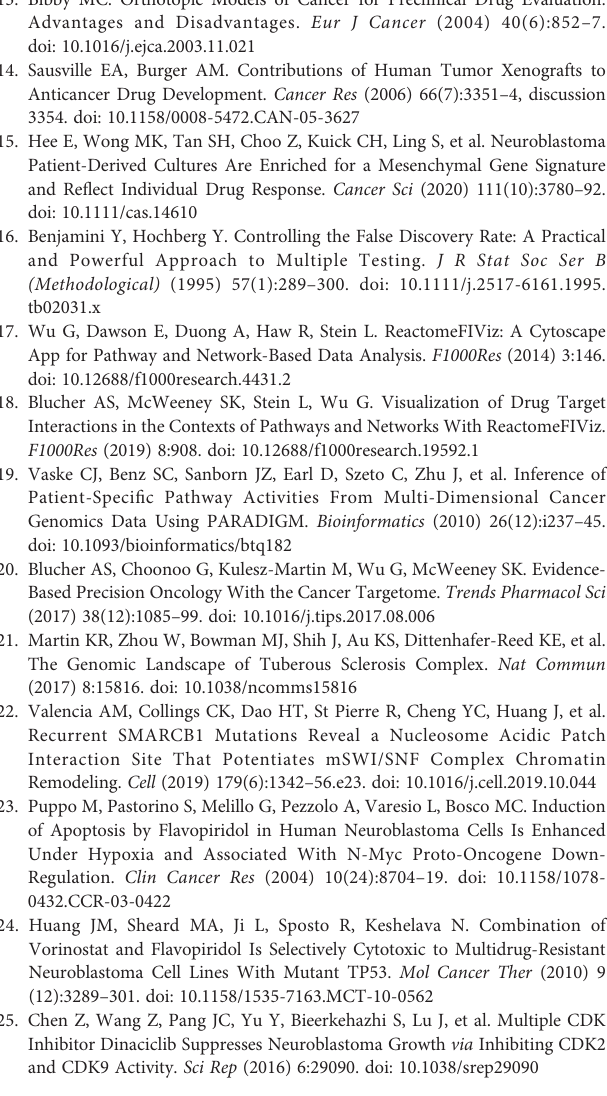
Supplementary Figure S3 | Heatmap of z-scores of 418 drugs (columns) and 136 genes (rows) using unsupervised Euclidean clustering. Blue-red color scale highlights gene-drug pairs with 2.5% top- and bottom-most z-scores. Signi fi cant clusters of genes and drugs are annotated, and corresponding OCCRA panels for respective genes are indicated in grey and black on the right panel. Supplementary Figure S4 | Scatterplots of cytotoxicity against copy number for top 6 false negative gene-drug pairs, ranked left to right by product of cytotoxicity (%) and z-score. Clinical-pathological characteristics of individual PDC lines are re fl ected in legend. INPC, International Neuroblastoma Pathology Classi fi cation; UH, unfavorable histology; FH, favorable histology.